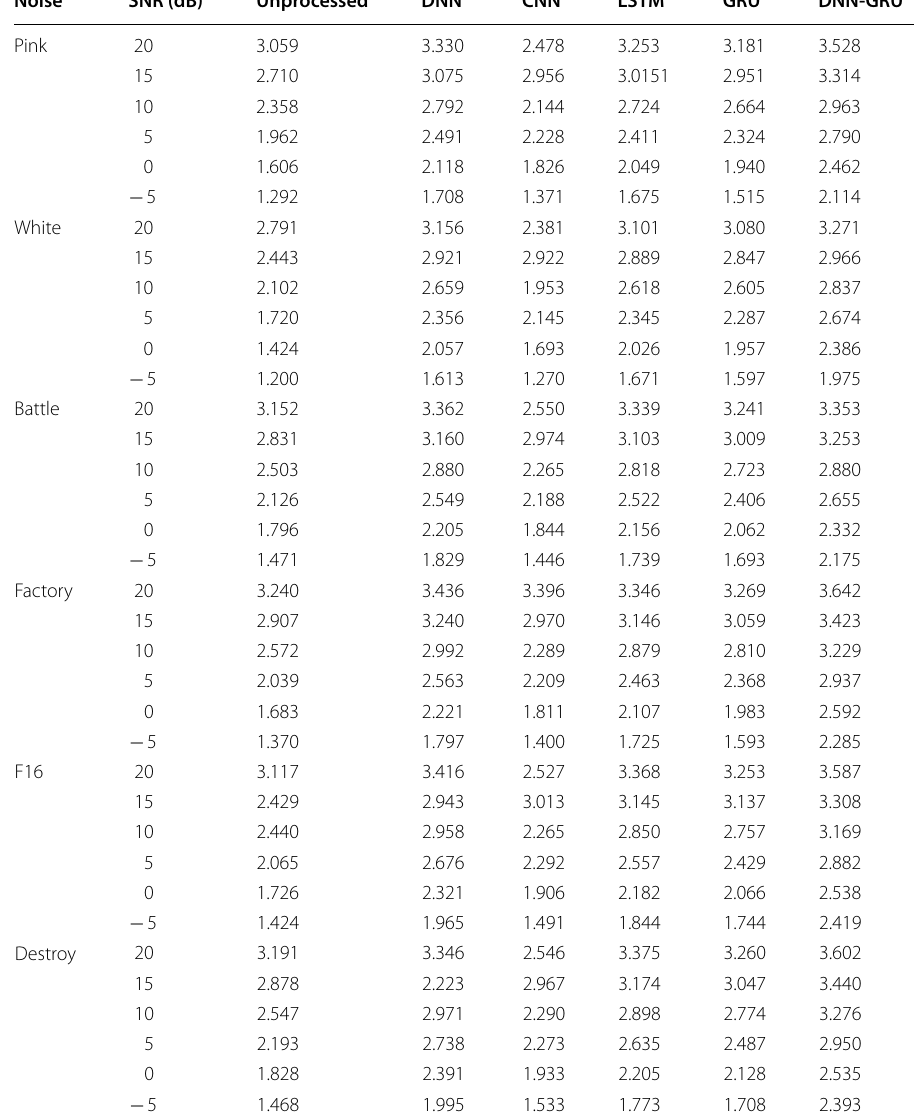
Table 1 PESQ comparison on the test set at different input SNRs of unseen noise environments Noise Pink